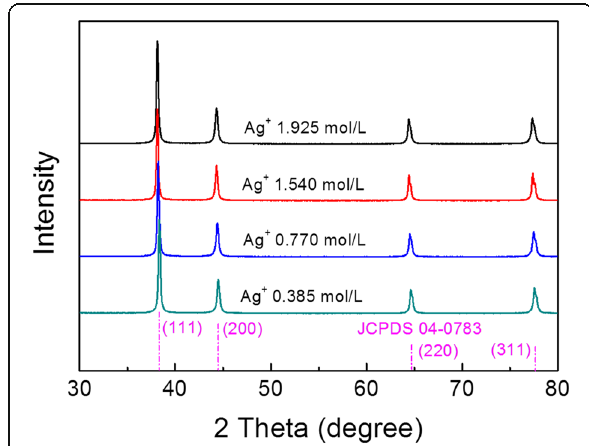
Fig. 1 XRD patterns of Ag NPs synthesized using different Ag + concentrations. The corresponding Ag + concentrations of